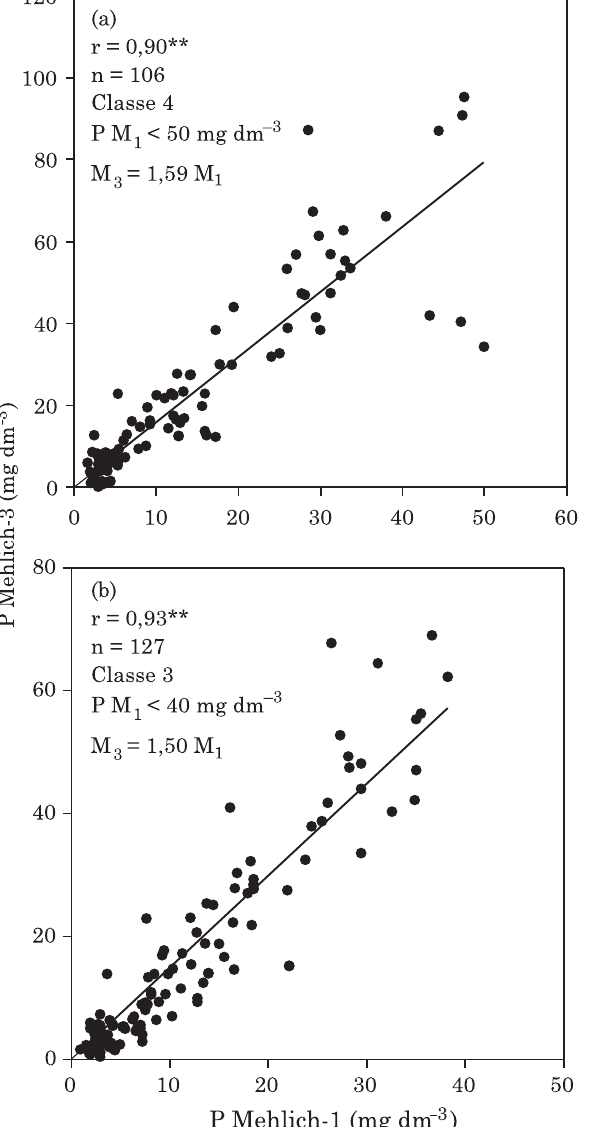
Figura 2. Correlações entre os teores de P extraído pelas soluções de Mehlich-1 e de Mehlich-3, para solos com teores de argila = 200 g dm -3 (Classe 4)